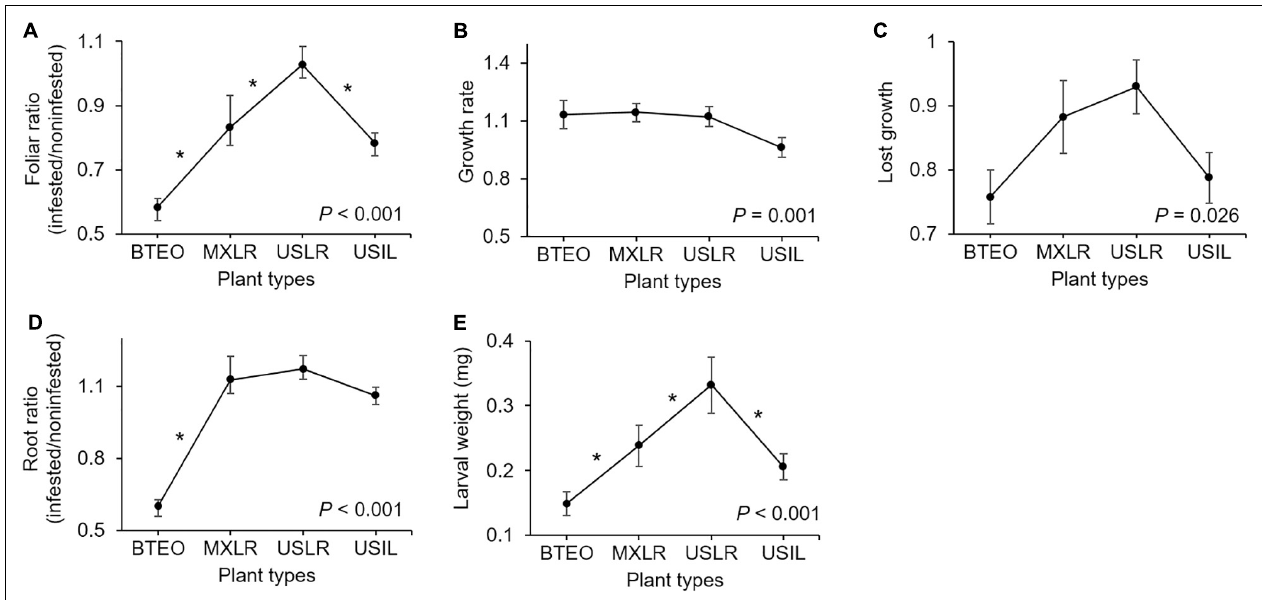
FIGURE 2 | Paired comparisons between per-plant type means ( ± SE) of plant and Western corn rootworm (WCR) variables associated with plant resistance. Plant types are ordered left to right from most ancestral to most derived: Balsas teosintes (BTEO), Mexican maize landraces (MXLR), US maize landraces (USLR), and US maize inbred lines (USIL). Asterisks indicate significant difference ( a priori contrasts with critical P ≤ 0.017, per Bonferroni correction) between means of contiguous plant types representing the domestication (BTEO vs. MXLR), spread (MXLR vs. USLR), and breeding (USLR vs. USIL) transitions in maize; univariate analysis of variance (ANOVA) P statistics are inset in each plot (see Table 1 for complete statistics). (A) Foliar ratio (= above-ground weights after 10 days, WCR-infested plants/non-infested plants); (B) Growth rate (=ratio between WCR infested seedling stem diameter at days 0 and 10 of the assay); (C) Lost growth (=stem diameter ratio after 10 days of WCR-infested plants/non-infested plants); (D) Root ratio (=belowground weights after 10 days of WCR-infested plants/non-infested plants). (E) Larval weight (=weights of WCR larvae after 10 days).